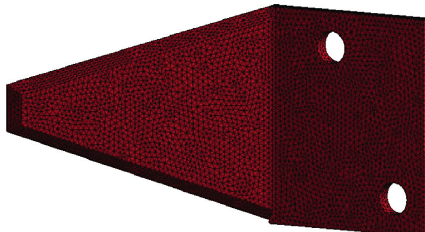
Figure 4: Finite element model of the